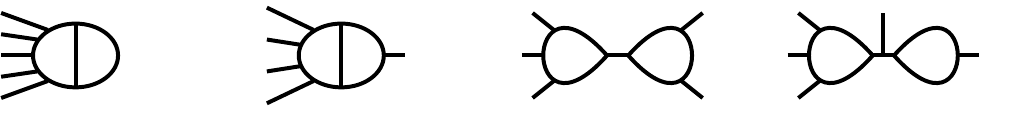
Figure 4 . Some of the maximal degeneration graphs of class (2), namely containing one or several subgraphs with one, two, or three external edges, whose contributions to the genus-two amplitude with (cid:12)ve massless external states